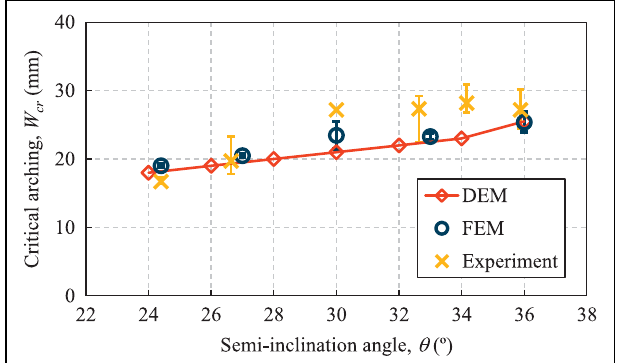
FIGURE 3 | The variation of the critical outlet width with increasing hopper semi-inclination angle, predicted by the DEM and FEM models along with the experimental measurements. The error bar of the experimental data represents the min-max range of multiple